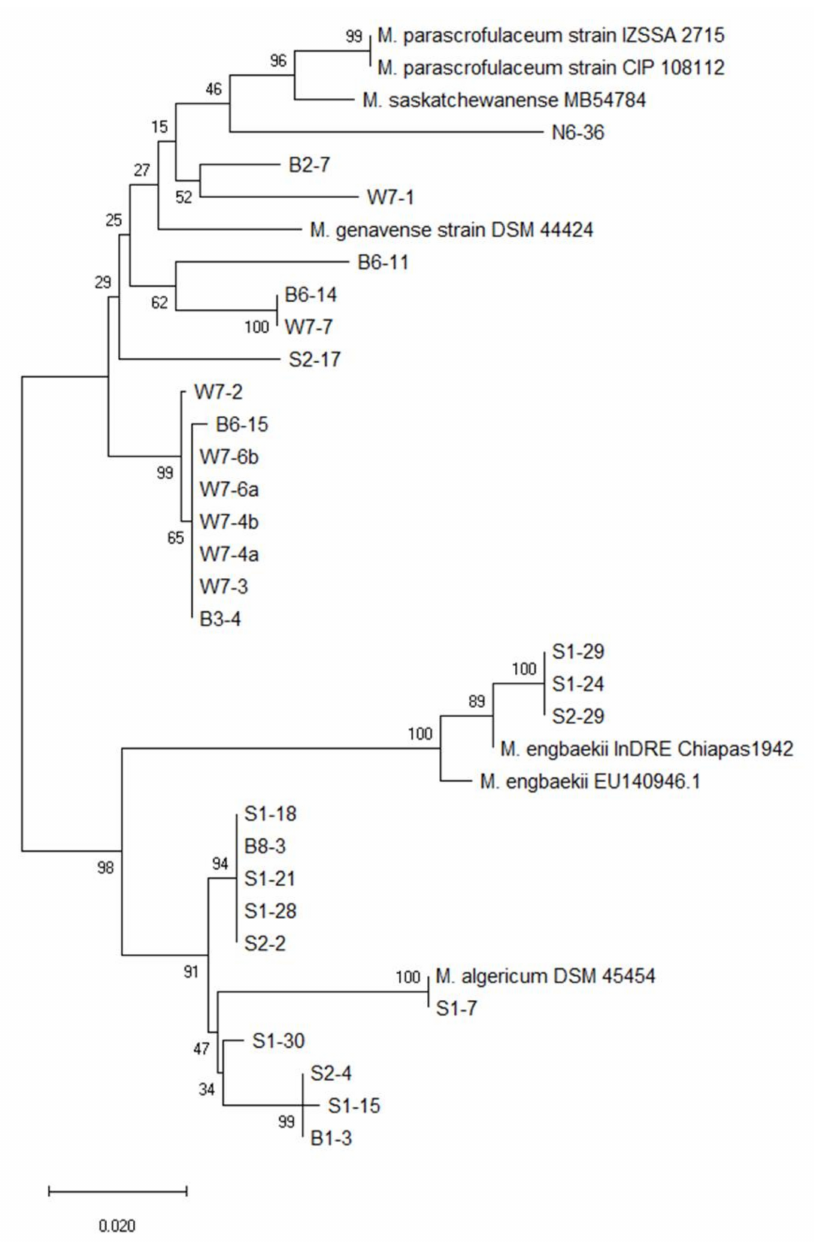
Figure 6. Phylogenetic analysis of non-MAC SGM isolates in South Korean soils based on the hsp65 gene sequences of the isolates and previously reported strains in NCBI GenBank. The tree was created using the neighbor-joining method, and bootstrap analysis was performed from 1000